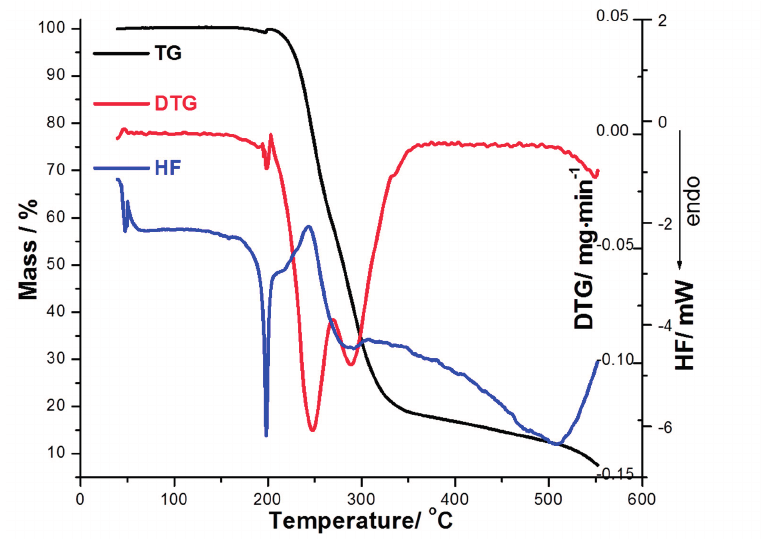
Figure 3. The thermoanalytical curves (TG/DTG/HF) recorded with β = 15 °C/min for SB2